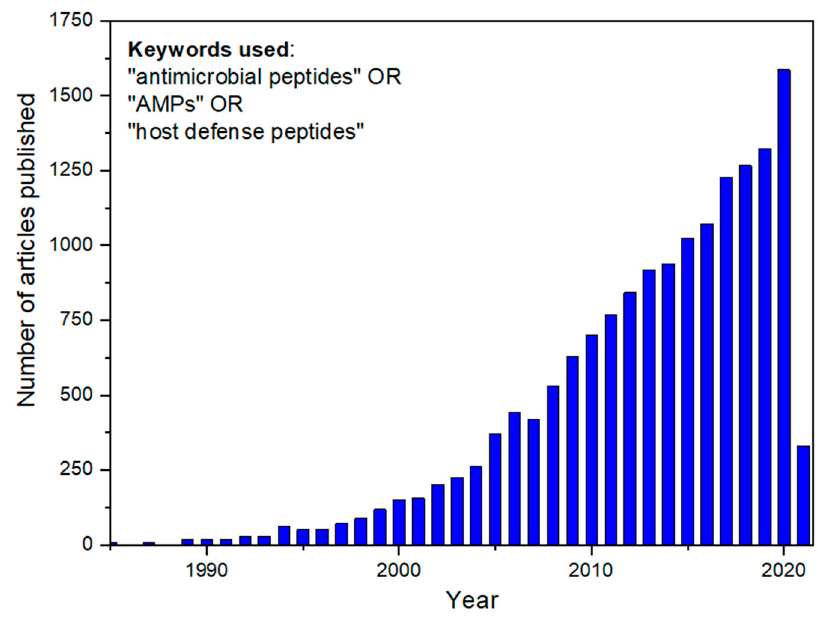
Figure 2. Number of scientific articles published in academic journals since 1985. The inset shows the keywords employed to perform the search. For the 2021 year, showing the number of articles published until the date of data search (3 March 2021), the number of papers (330) is higher than that corresponding to the whole of 2004.